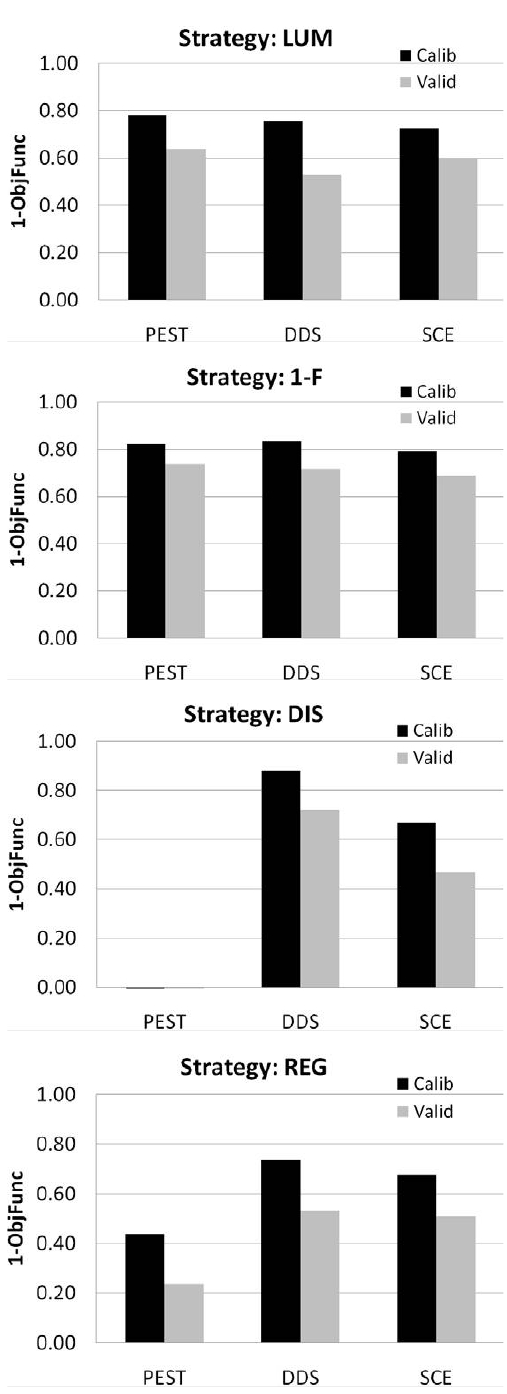
Fig. 6. Mean model performance calculated as 1.00 minus the av- erage over the objective function values (Eq. 9) for the three catch- ments, Derneburg, Reckershausen and Wieckenberg for all combi- nations of calibration strategies and optimisation algorithms. The optimum result would be